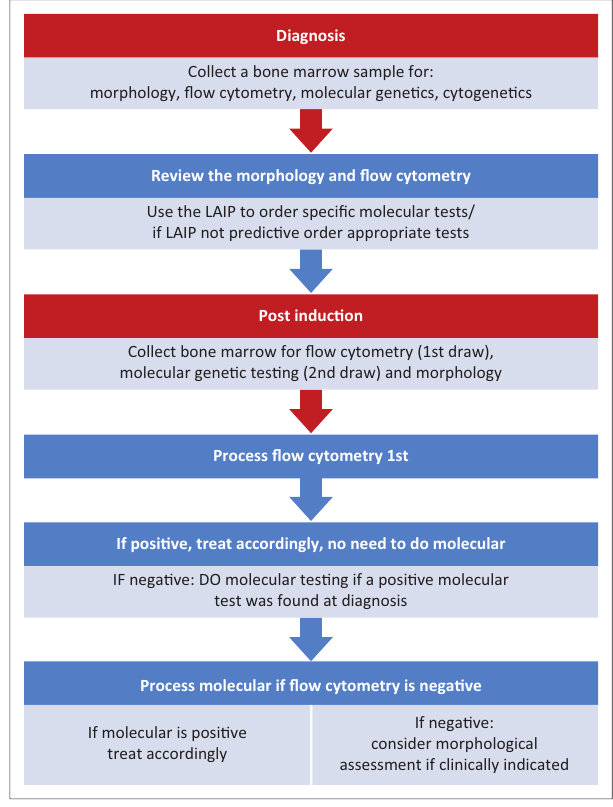
FIGURE 6: Proposed testing algorithm for minimal residual